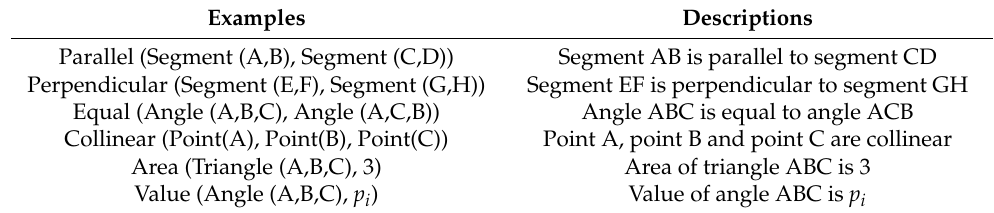
Table 2. Examples of predicates.